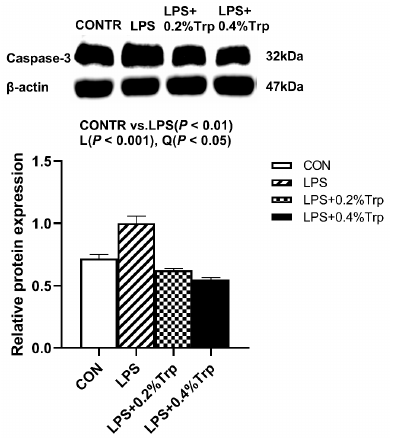
Figure 3. Impact of tryptophan supplementation on the ratio of caspase-3/ β -actin after 4 h of E. coli LPS challenge in ileal mucosa of weaning piglets. CONTR, control; LPS, lipopolysaccharide; Trp, tryptophan. The band shown is the representative Western blot images of caspase-3. The data are presented as means ± SEM. CONTR vs. LPS was employed to obtain the response to LPS challenge. Linear and quadratic polynomial contrasts were employed to obtain the response of tryptophan supplementation in LPS-challenged piglets. Note: L (linear), Q